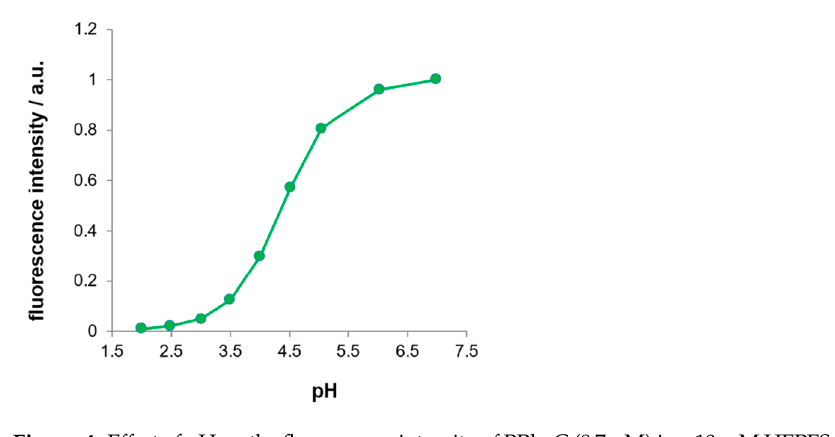
Figure 3. Effect of pH on the ( a ) absorption spectra, and ( b ) fluorescence spectra (excited at 621 nm) of BRhoC (8.7 μ M) in a 10 mM HEPES aqueous solution (pH 2–7).